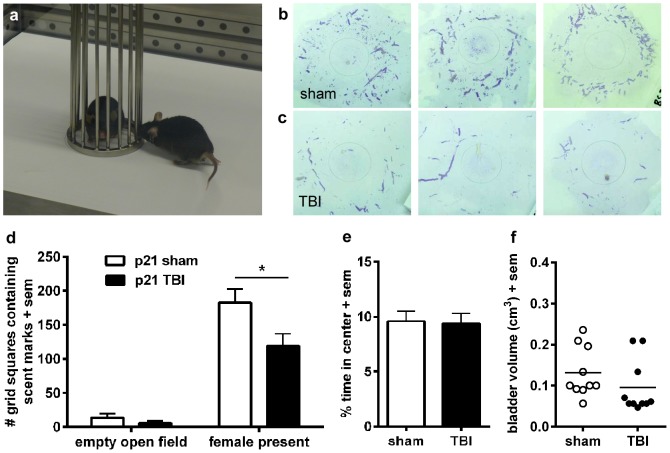
Reduced scent marking indicates impaired sociosexual communication after pediatric TBI.Scent marking by sham and TBI mice was assessed in an open field arena lined with absorbent paper, in the presence and absence of a cage-enclosed novel female mouse (a). Representative examples from sham mice and after injury at p21 are shown in panels (b) and (c), respectively. All mice produced more scent marks in the presence of a stimulus female compared to an empty arena (d). However, despite comparable production of scent marks at baseline (empty open field), TBI mice deposited significantly fewer scent marks in response to a novel female, compared to sham-operated mice (*p<0.05). This reduction was unlikely due to potential changes in mobility, anxiety or gross bladder dysfunction, as measures of anxiety (e) and bladder capacity (f) were comparable.